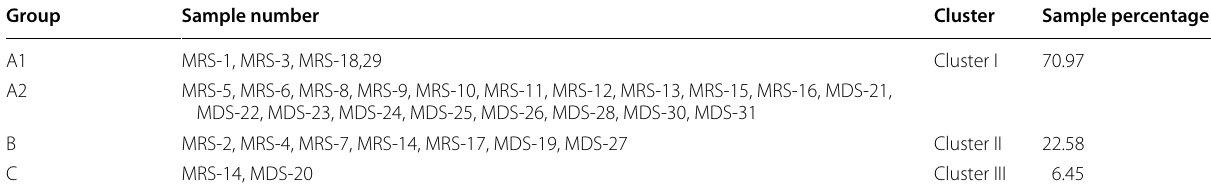
Table 5 Cluster analysis of the water